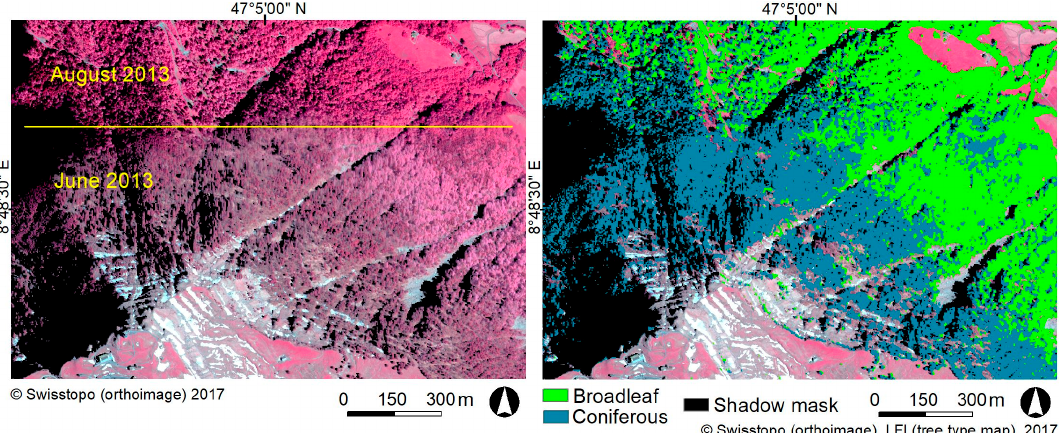
Figure 9. Illustration of several constraints of the tree mapping approach. CIR aerial image of a part of a subset in the Prealps ( Left ) that consists of two different images from different dates, with clear differences in the appearance of the broadleaved and coniferous trees. Rigorous shadow masking (black) and the implementation of topographic variables enabled a reasonable prediction of the tree types ( Right ).